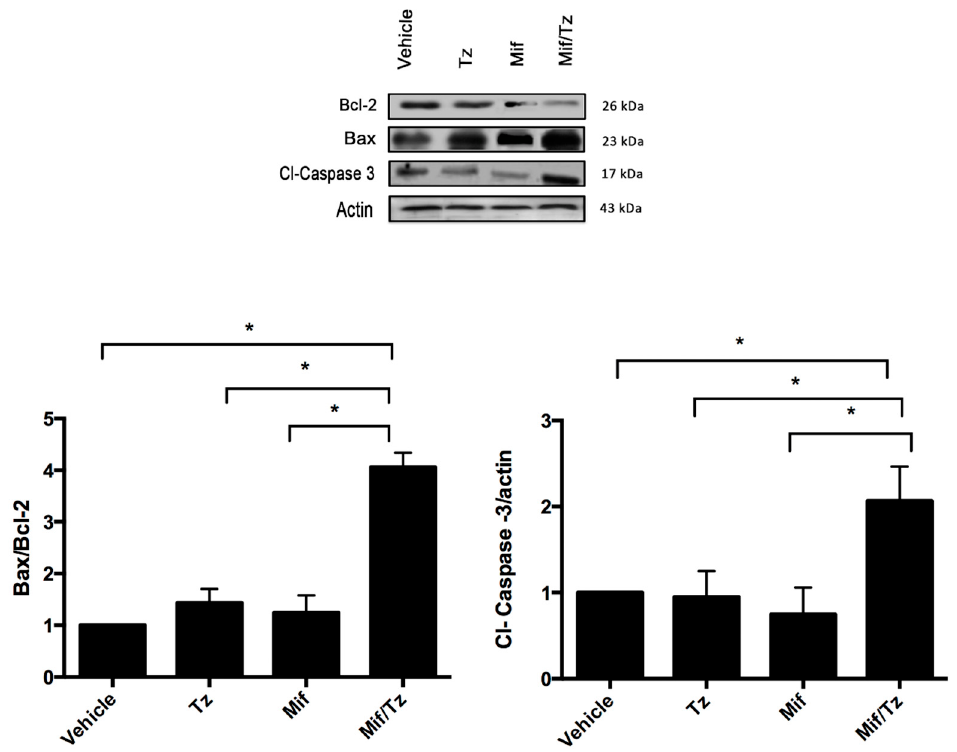
Figure 4. Expression of apoptotic proteins. Representative western blot results and densitometric analysis of Bcl-2, Bax and Cl-Caspase 3. Data are expressed as the mean ± SEM from three independent experiments. * Indicates a significant difference ( p < 0.05) between Mif/Tz and the other groups with tumor cell implantation (given Tz, Mif or the vehicle).